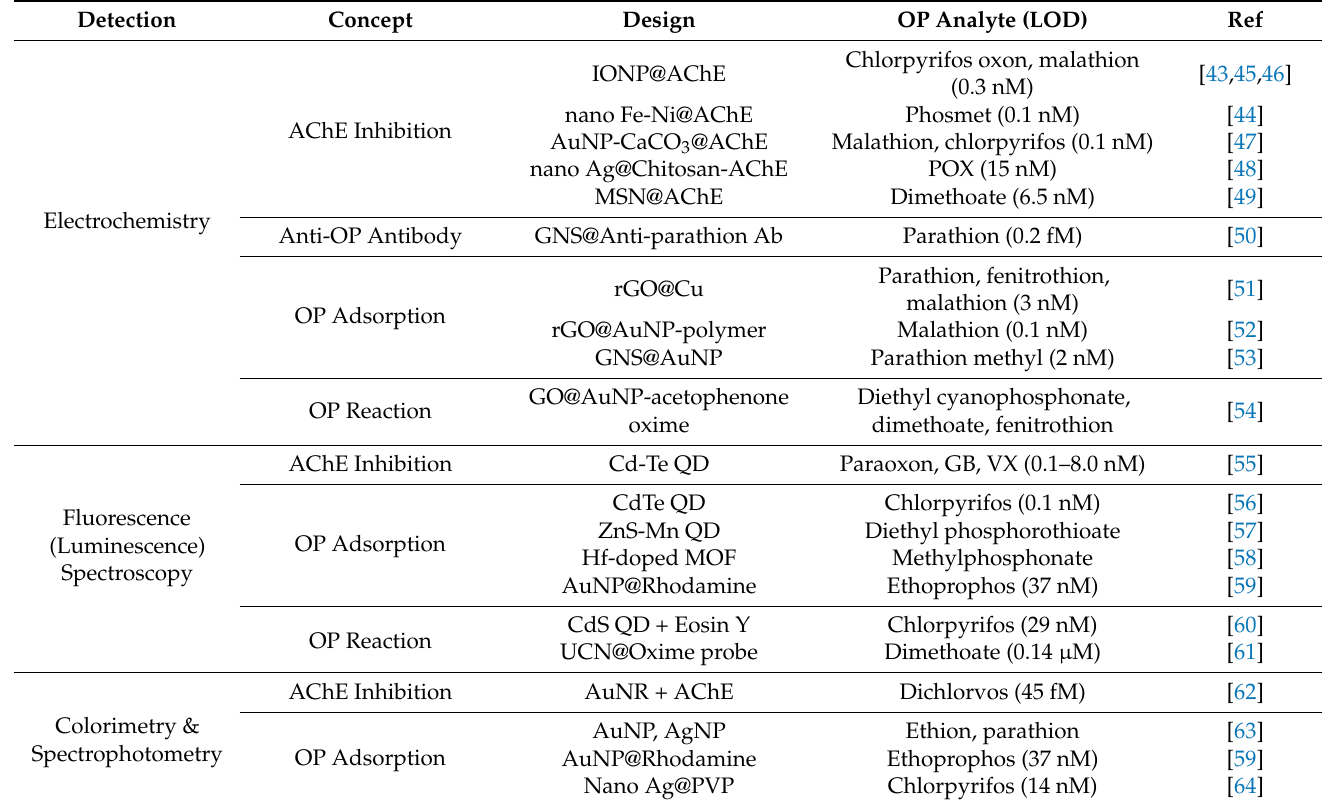
Table 1. Nanomaterial-enabled sensors developed for OP